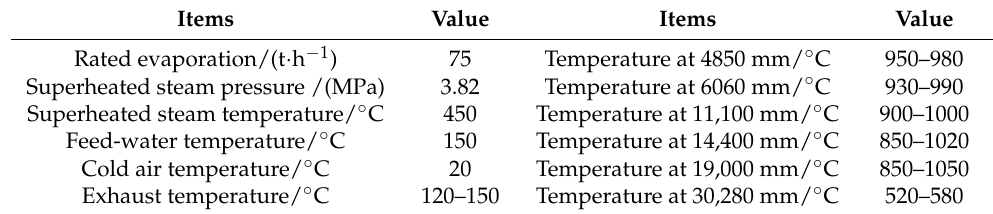
Table 1. Design and operating parameters of the boiler.